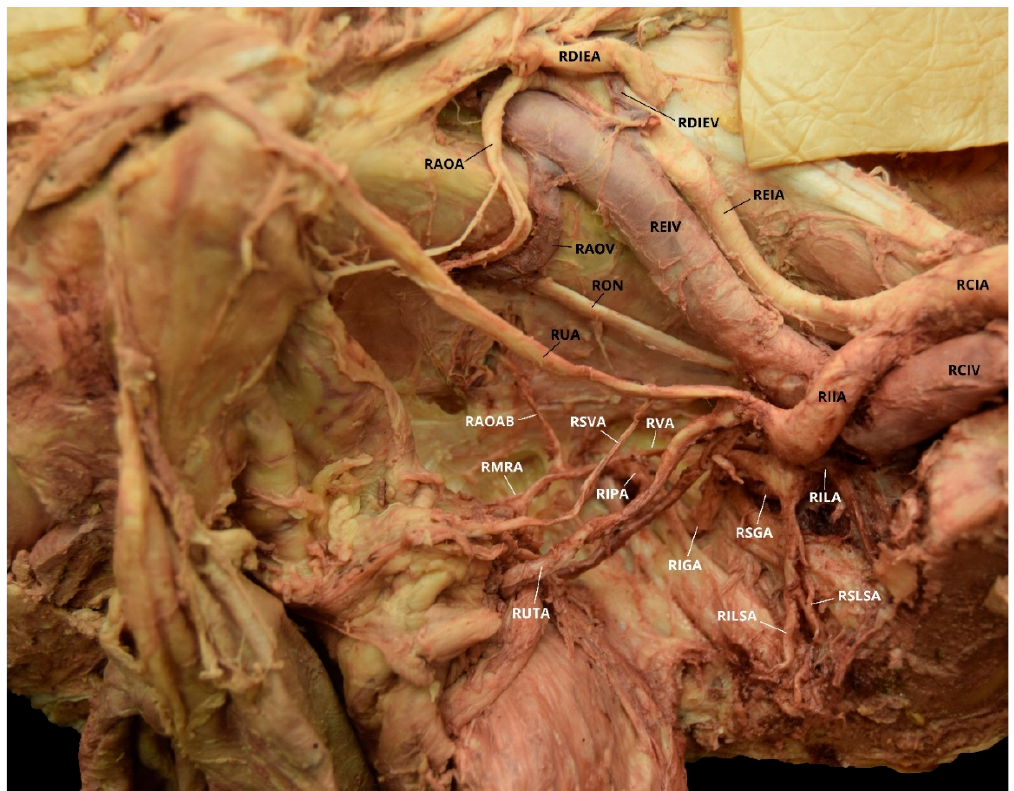
Figure 9. Facilitated display highlighting the right internal iliac artery branches with the right aberrant obturator artery for Case 5. RAOA = Right Aberrant Obturator Artery; RAOAB = Right Accessory Obturator Artery Branch; RCIA = Right Common Iliac Artery; RCIV = Right Common Iliac Vein; RDIEA = Right Deep Inferior Epigastric Artery; RDIEV = Right Deep Inferior Epigastric Vein; REIA = Right External Iliac Artery; REIV = Right External Iliac Vein; RIGA = Right Inferior Gluteal Artery; RIIA = Right Internal Iliac Artery; RILA = Right Iliolumbar Artery; RILSA = Right Inferior Lateral Sacral Artery; RIPA = Right Internal Pudendal Artery; RMRA = Right Middle Rectal Artery; ROA = Right Obturator Artery; RON = Right Obturator Nerve; RSGA = Right Superior Gluteal Artery; RSLSA = Right Superior Lateral Sacral Artery; RSVA = Right Superior Vesical Artery; RUA = Right Umbilical Artery; RUTA = Right Uterine Artery; RVA = Right Vaginal Artery.